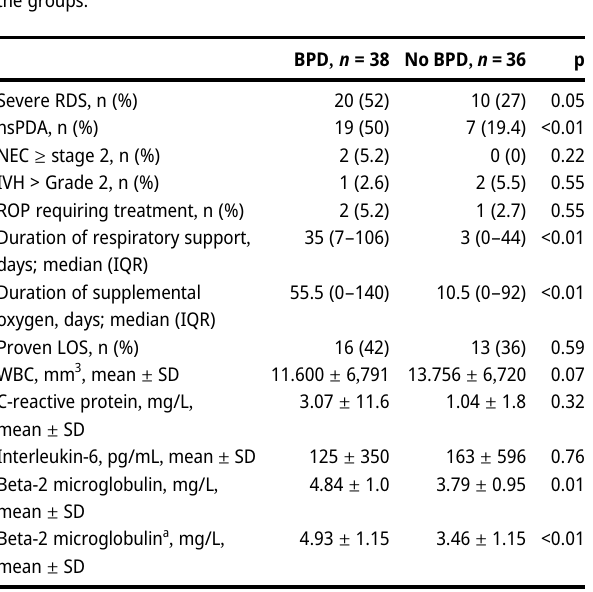
Table  : Comparison of neonatal morbidities laboratory analysis within the groups.